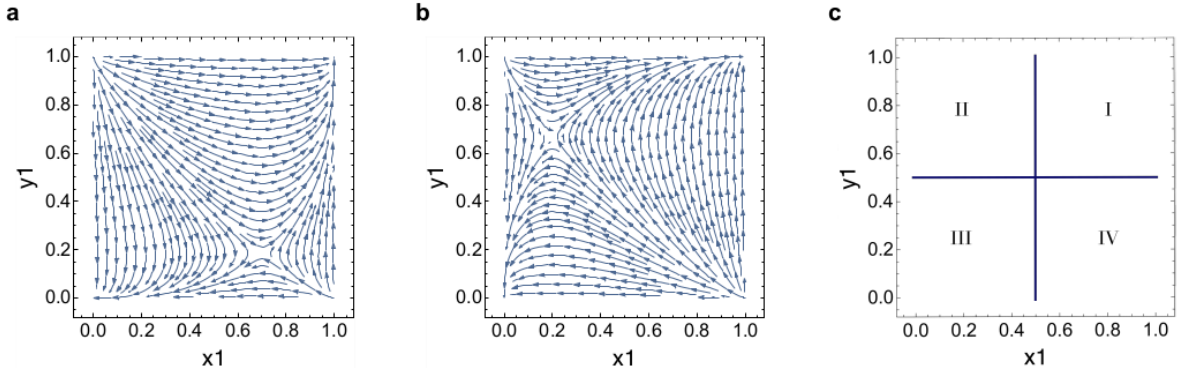
Figure 2. Saddle point geographies with theoretical GameState payoffs, see Figure 1. ( a ) Bear GameState, n = 0; ( b ) bull GameState, n = 1; ( c ) quadrant legend. x 1 and y 1 denote laborer and firm preference for gig work, respectively, where the value of 1.0 represents a universal gig strategy and the value of 0.0 represents a universal employee